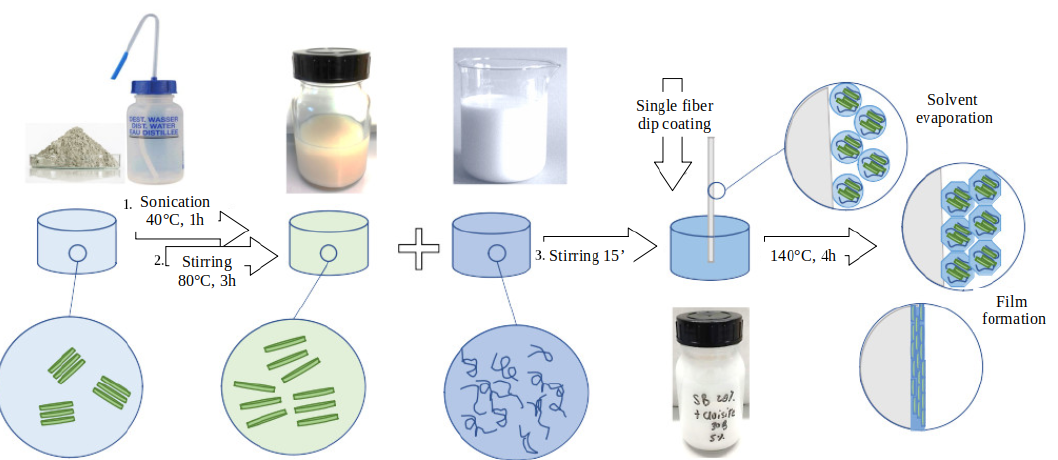
Figure 2. Schematic representation of dispersion preparation and fiber surface treatment